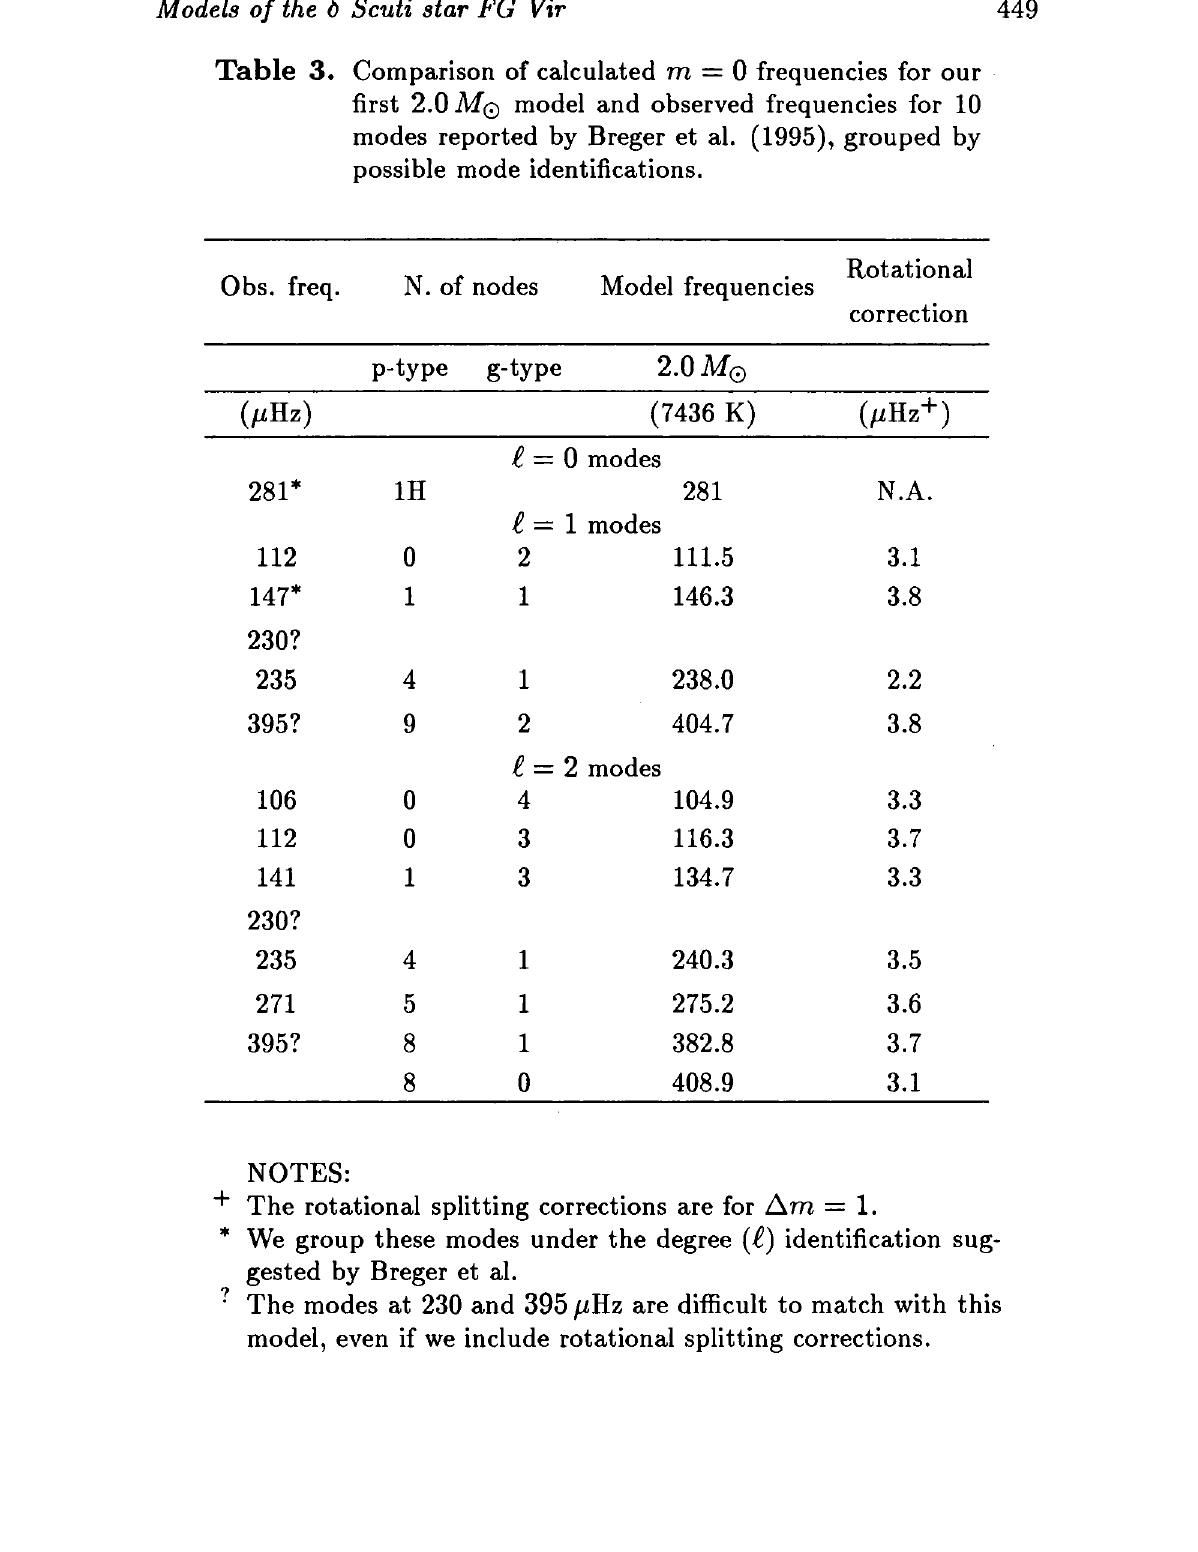
Table 3. Comparison of calculated m = 0 frequencies for our first 2.0 MQ model and observed frequencies for 10 modes reported by Breger et al. (1995), grouped by possible mode